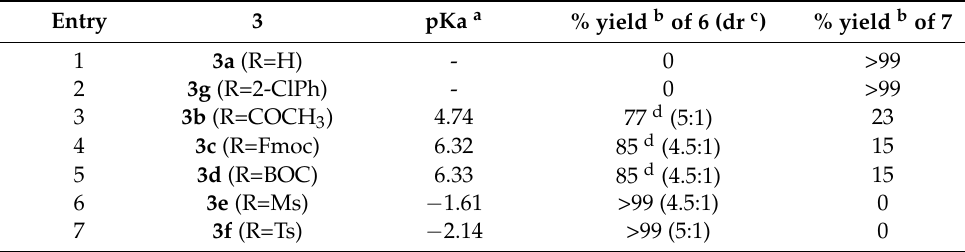
Table 1. Interrupted intramolecular HAM reaction of 2-vinylanilines 3